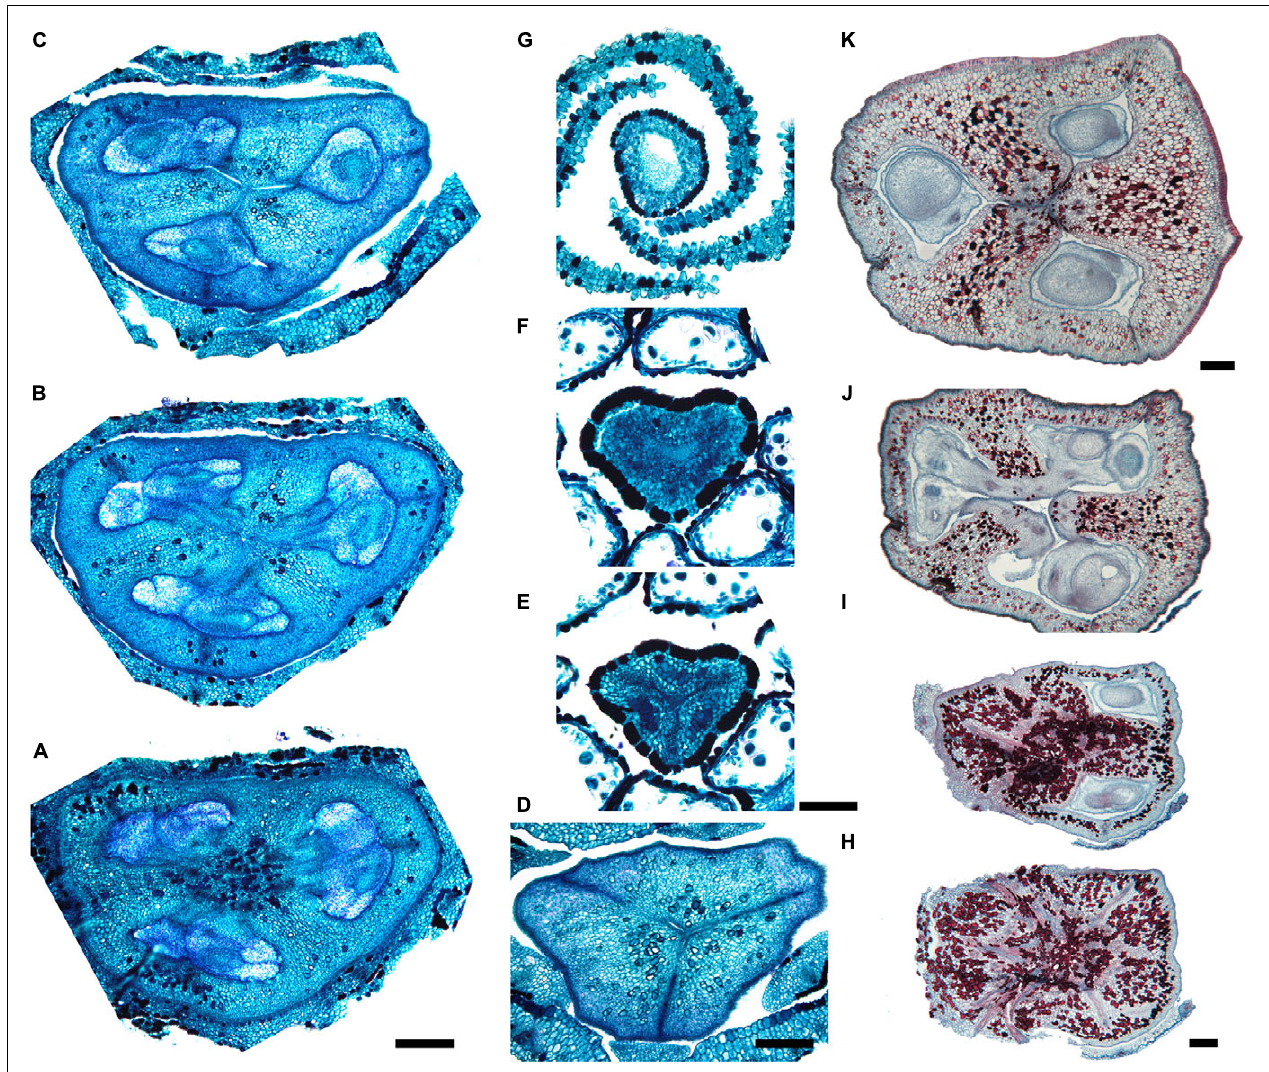
FIGURE 7 | Gynoecium of Saxofridericioideae-Schoenocephalieae. Guacamaya superba and Schoenocephalium cucullatum. (A–G) Serial cross-sections through gynoecium of Guacamaya superba . (A) Basal part of ovary, close to synascidiate zone. (B) Middle part of ovary, symplicate zone. (C) Distal part of ovary, symplicate zone. Note almost open ventral slits. (D) Ovary roof with triradial canal in its center, symplicate zone. (E,F) Style with triradial canal filled with mucilage, symplicate zone. (G) Stigma (surrounded by contort petals, symplicate zone. (H–K) Serial cross-sections through gynoecium Schoenocephalium cucullatum. (H) Receptacle below ovary. (I) Synascidiate zone. Note thin blue-colored epidermis in panels (H,I) . (J) Symplicate zone, level of placentae. (K) Symplicate zone, level above placentae close to ovary roof. Scale bars = 200 mkm in panels (A–D) , 100 mkm in panels (E–G) , 20 mkm in panels (H–J), and 10 mkm in panel (K)